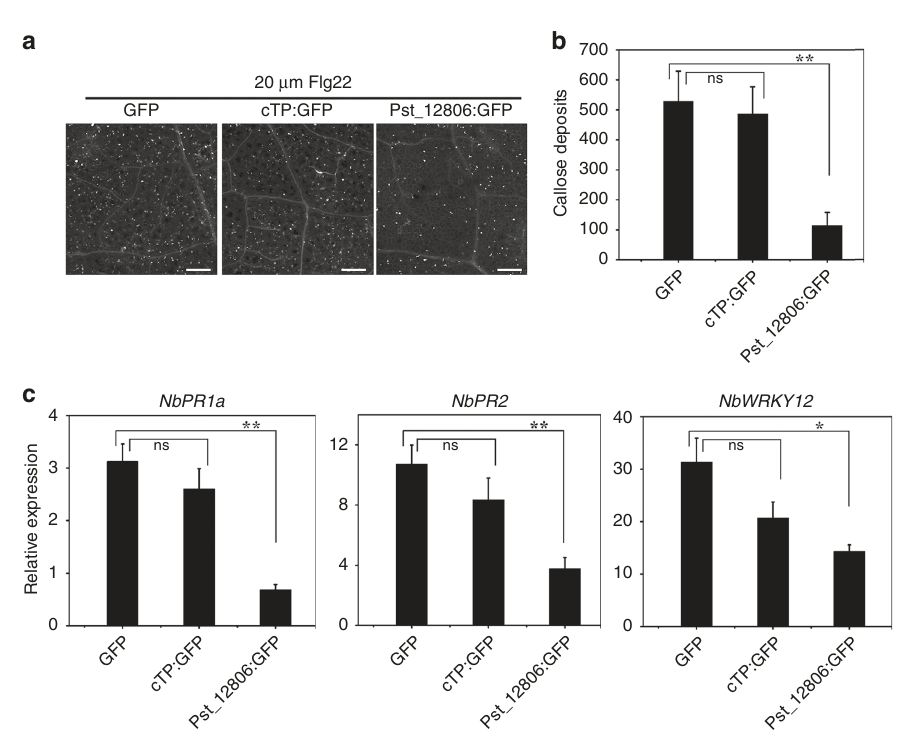
Fig. 3 Suppression of PAMP -triggered PTI. a Callose deposition induced by 20 μ M Flg22 in N . benthamiana transiently expressing Pst_12806 Δ SP :GFP,cTP: GFP or GFP clone. The representative images were captured at 12 h after in fi ltration with Flg22. Bar = 200 μ m. b Pst_12806 suppresses callose deposits in N . benthamiana . The number of callose spots per 1-mm 2 areas was analyzed with the ImageJ software. Mean and standard deviation (SD) were calculated with results from three biological replicates. Asterisk (*) marks indicate signi fi cant difference (* P < 0.05; ** P < 0.01) based on unpaired two-tailed Student ’ s t test. c The relative expression levels of PR1 , PR2, and WRKY12 in N . benthamiana leaves transiently expressing Pst_12806 Δ SP :GFP,cTP:GFP or GFP clone after in fi ltration with Flg22 were assayed by qRT-PCR with the NbAct1 as a reference gene for normalization. Mean and standard deviations were calculated from three biological replicates. An asterisk indicates signi fi cant differences based on unpaired two-tailed Student ’ s t test with the P values marked (* P < 0.05; ** P < 0.01, ns not signi fi